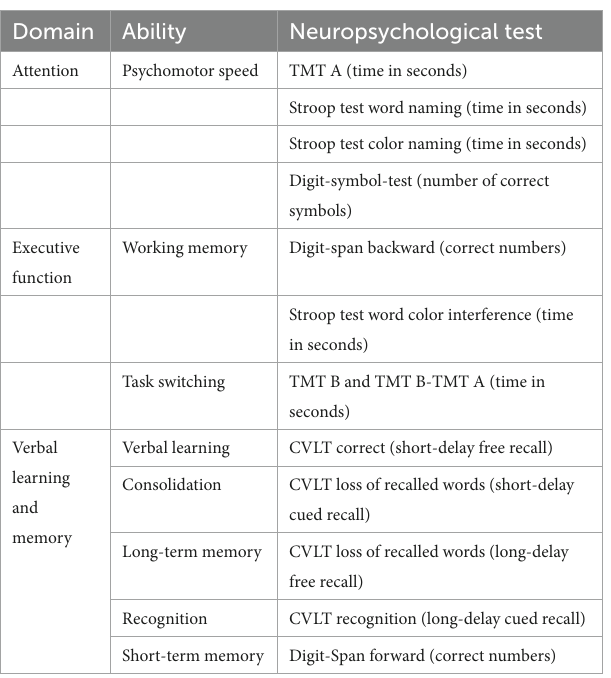
TABLE 1 Allocation of neuropsychological tests to cognitive domains